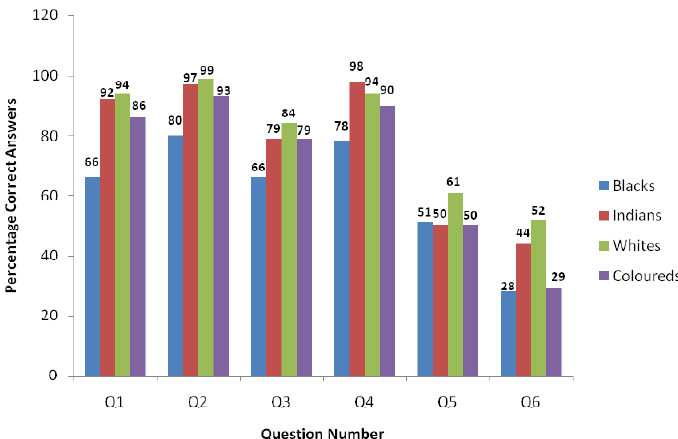
Figure 2: Showing the percentages of respondents within each race who gave the correct answers to questions 1-6. Indian and White respondents consistently appeared to have greater aware- ness on sunlight exposure.